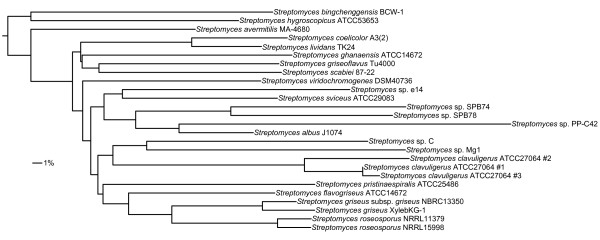
Phylogenetic tree of the Streptomyces genomes used in this study. This neighbor-joining phylogenetic tree is based on the average amino acid identity, calculated using each non-fragmented bidirectional best BLAST pair having ≥ 30% identities over ≥ 70% of both protein lengths. The tree was rooted based on a 16S rRNA gene tree constructed for all actinobacterial type strains which was consistent in all major respects to the tree presented here.